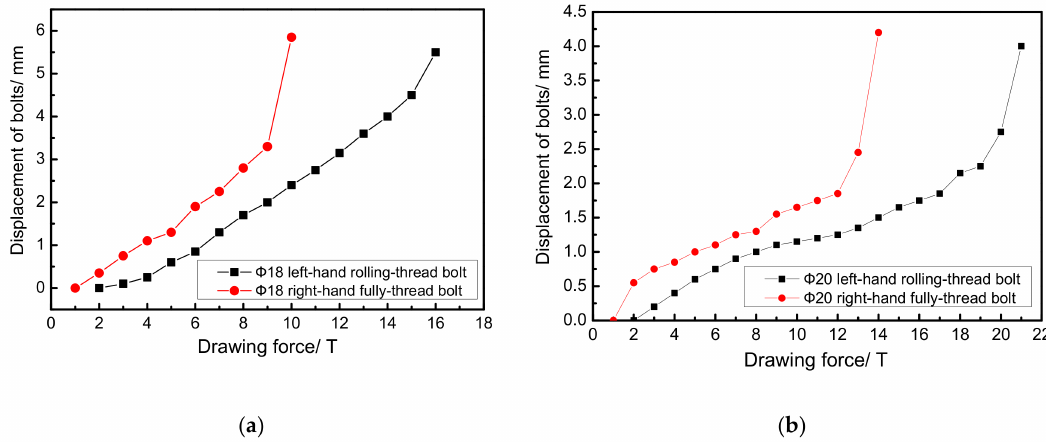
Figure 15. Relationship between the pull-out force and displacement of bolts in the pull-out tests. ( a ) Φ 18 thread steel bolt; ( b ) Φ 20 thread steel